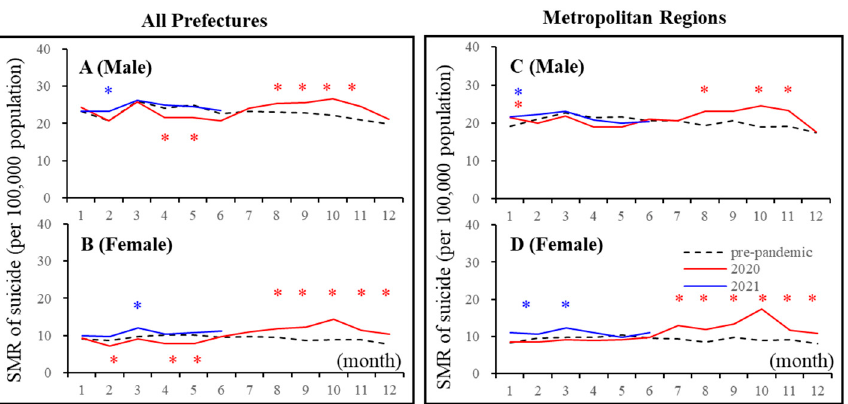
Figure 2. Temporal fluctuations of monthly standardised suicide mortalities (SMR-S) during COVID-19 pandemic period (2020–2021) compared to the average of the same month of SMR-S during the pre-pandemic period (2017–2019). Dotted black, red, and blue lines indicate the average of SMR-S for ( A ) males, ( B ) females of all 47 prefectures, and ( C ) males and ( D ) females of metropolitan regions. Ordinates indicate the SMR-S (per 100,000 people), and abscissas indicate the month. * p < 0.05, significant change using a linear mixed-effects model with Tukey’s multiple comparison. Red and blue asterisks indicate significant changes in SMR-S in 2020 and 2021, respectively, compared to the average SMR-S of the same month during the pre-pandemic